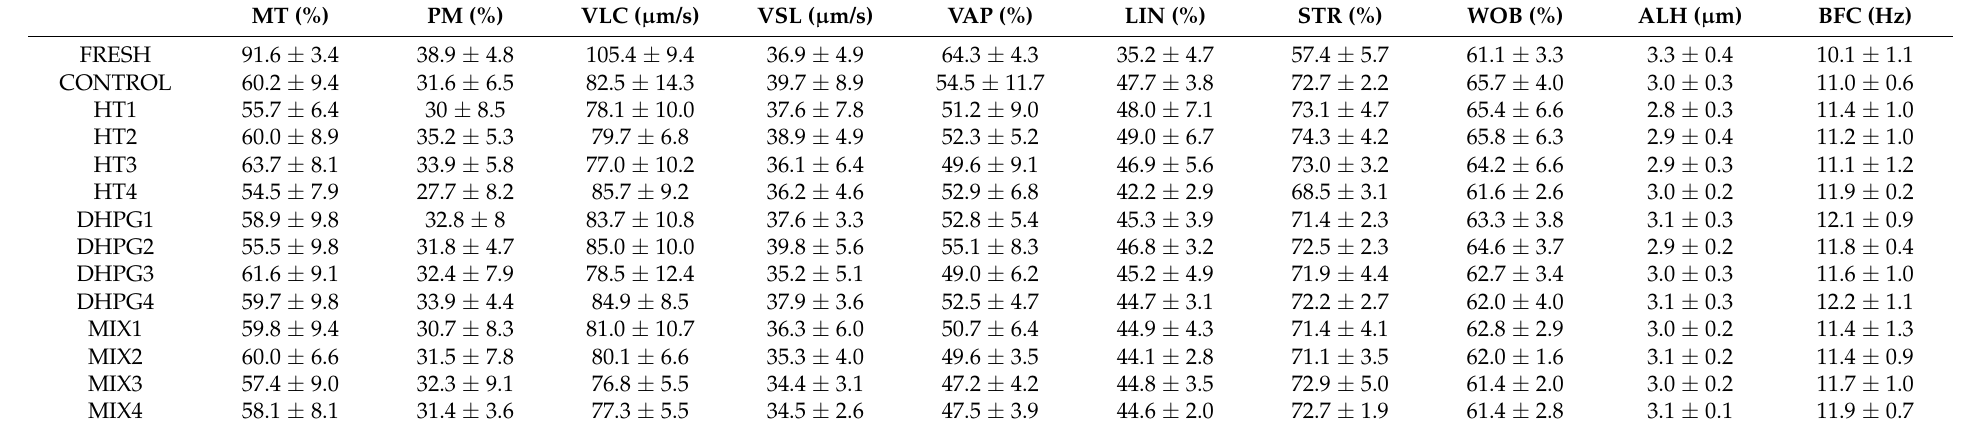
Table 2. Descriptive statistics of sperm motility and kinematic parameters in fresh and frozen-thawed buck sperm.